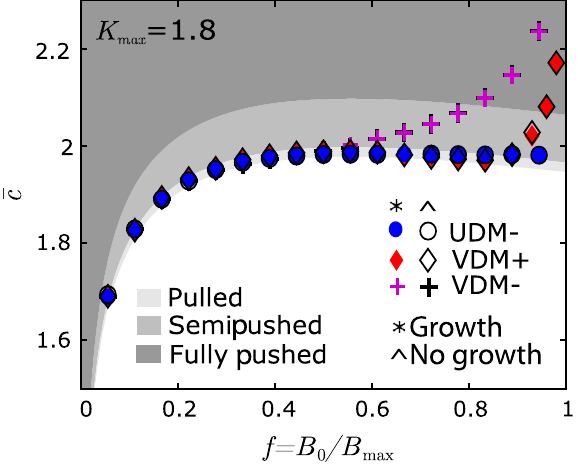
FIG. 13. Dimensionless front velocity ¯ c as a function of the bacteria fraction f , with shaded regions indicating the different expansion types, when bacteria grow logistically as described in Eqs. (E1a) – (E1c). As in Fig. 2(c), parameters are chosen to represent typical T7 expansions with β ¼ 50 , τ ¼ 18 min, and α B ¼ 0 . 1 min − 1 [21,32,35] corresponding to K ¼ 1 . 8 in max max our model. Additionally, a doubling time of 30 minutes is assumed to calculate the growth rate of the host bacteria. By comparison to the results obtained in the absence of bacterial growth [as in Fig. 2(c)], it can be seen that bacterial growth has no effect on the transition to pushed expansions.